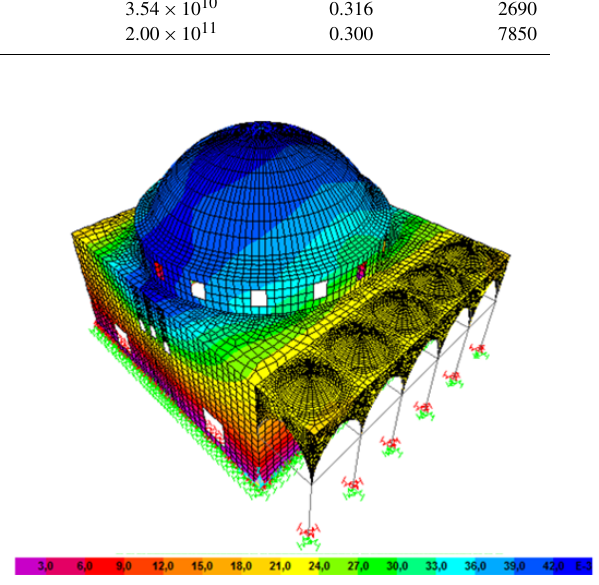
Figure 5. Maximum displacements contour diagram of the mosque with 16 window openings under dead load and earthquake load in the x direction (G +